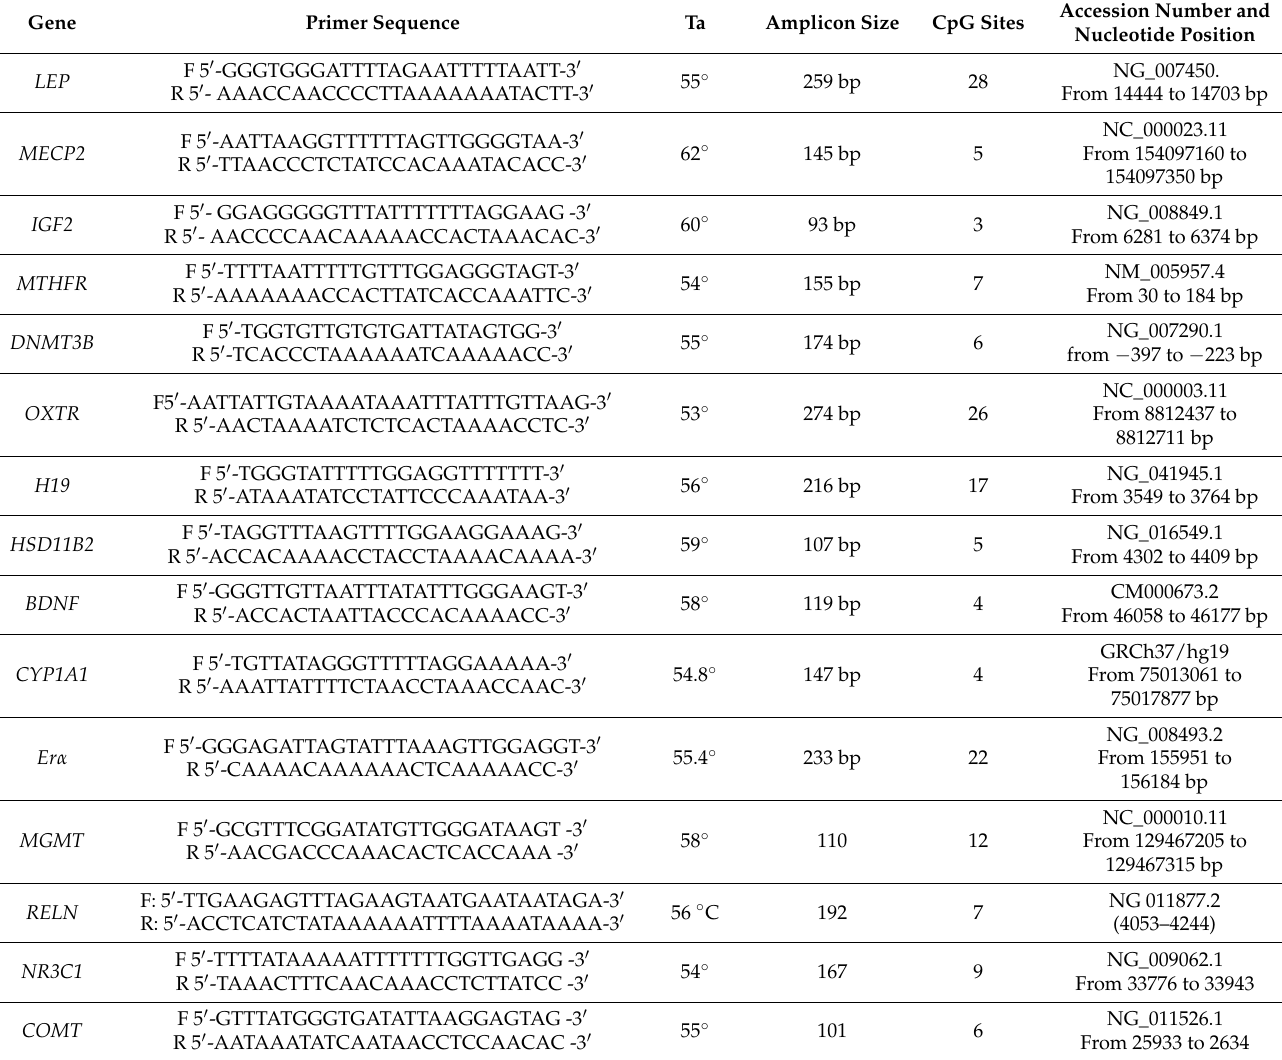
Table 4. Main characteristics of the designed primers. Annealing temperature (Ta), amplicon size and number of CpG sites included in the analyzed amplicons are